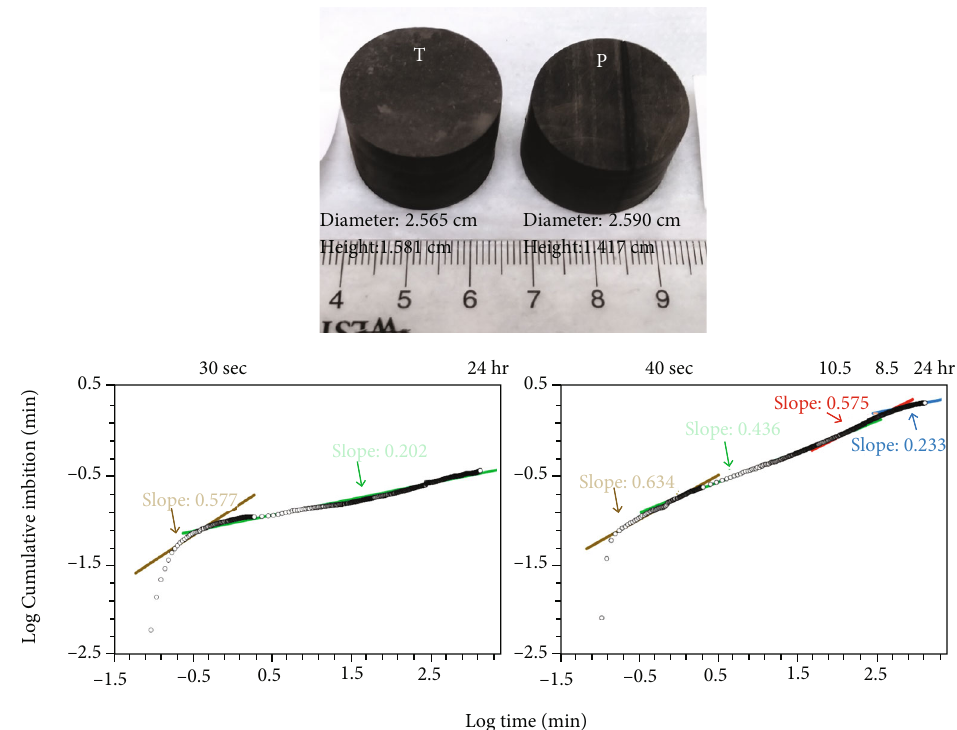
Figure 8: (Top) Picture of Barnett Shale sample (porosity at 13%) with T (left) and P (right) directions. (Bottom) Water imbibition results for the Barnett Shale sample under initially dry condition for T and P